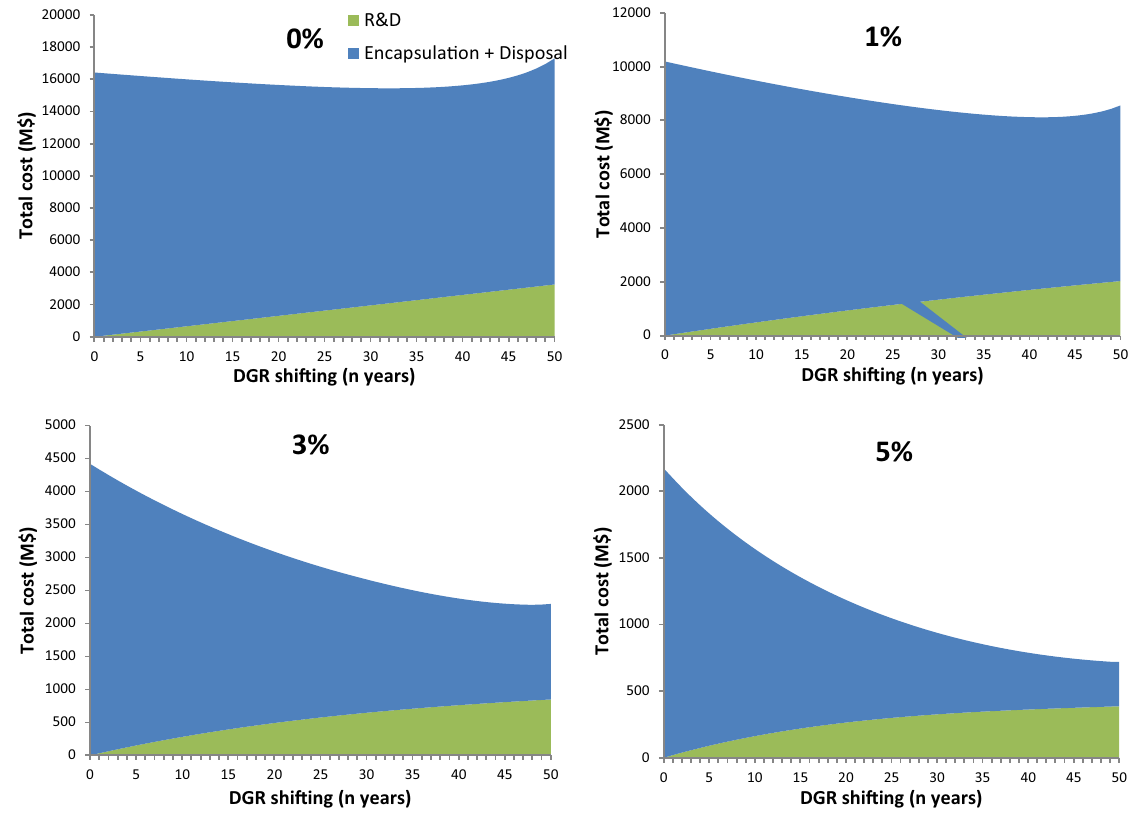
Fig. 12. Effect of reprogramming DGR deployment for n years while maintaining the initial closure date (with